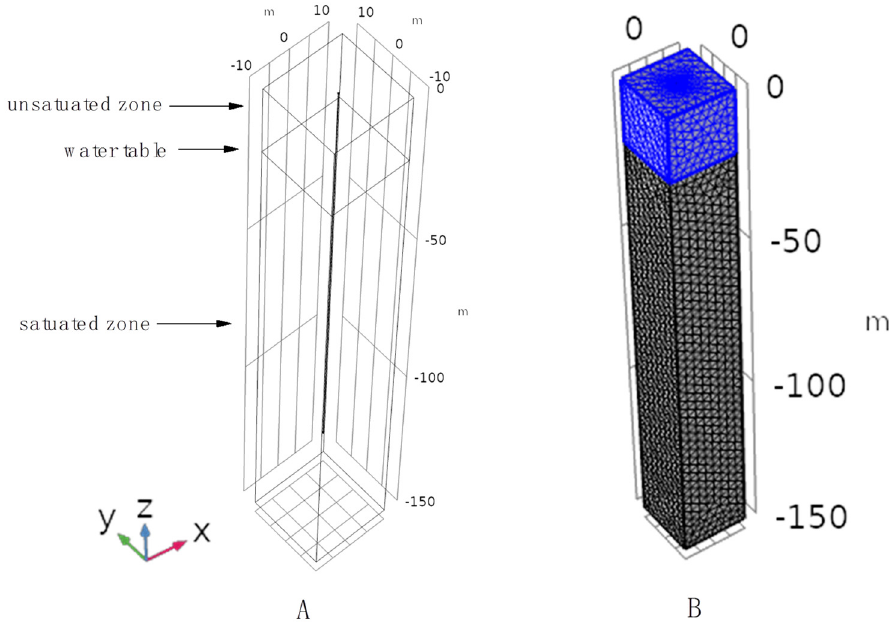
Figure 8. Geometric model of numerical simulation ( A ) Model construction; ( B ) Meshing.